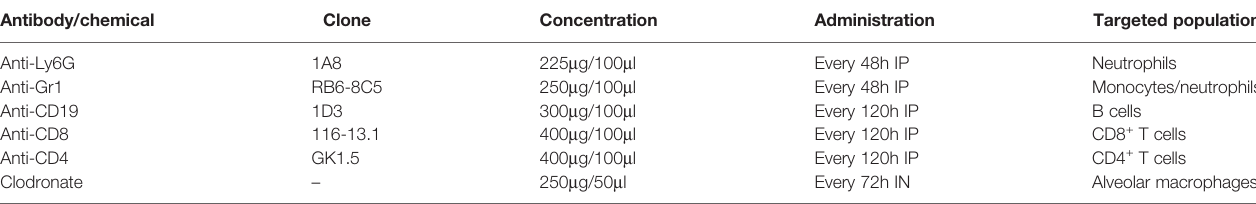
TABLE 1 | Reagents used for in vivo depletions. Antibody/chemical Clone Concentration Administration